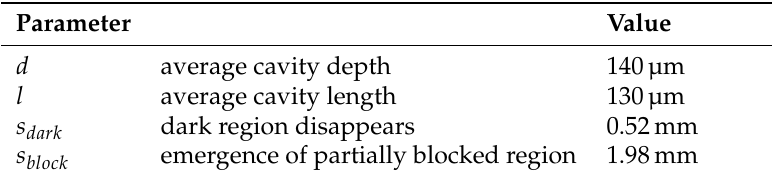
Table 1. Two-cavity fiber